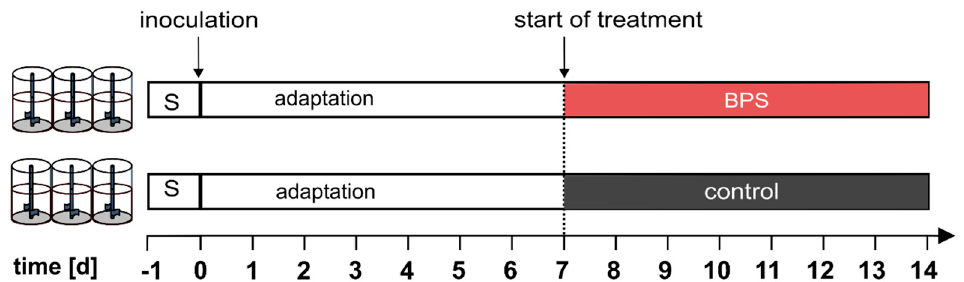
Figure 1. Experimental set-up of the bioreactor run: six bioreactors were inoculated with 1 x 10 9 Figure cells/250 mL and run for 7 days under continuous culture conditions. On day 7, three bioreactors were